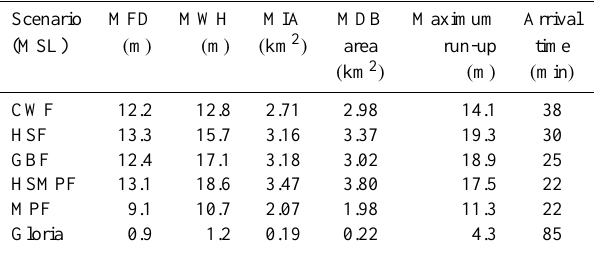
Table 2. Synthesis of the results: MFD, MWH, MIA, MDB area, maximum run-up, and arrival time for all scenarios at